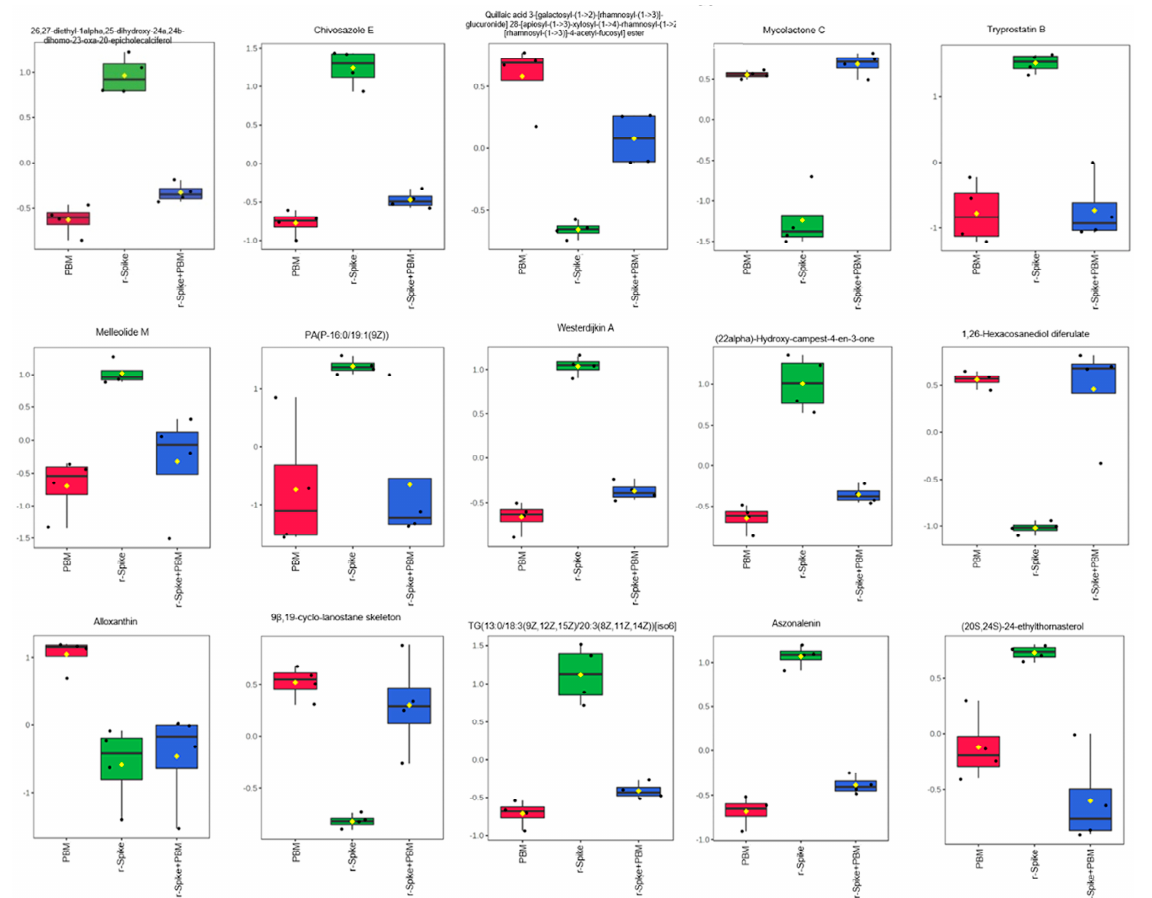
Figure 6. Boxplot plots of the most critical metabolites to differentiate the PBM, rSpike, and (rSpike + laser) after 24 h of treatment. Boxplot plots refer to the 15 primary metabolites expression between groups after 24 h of treatment.